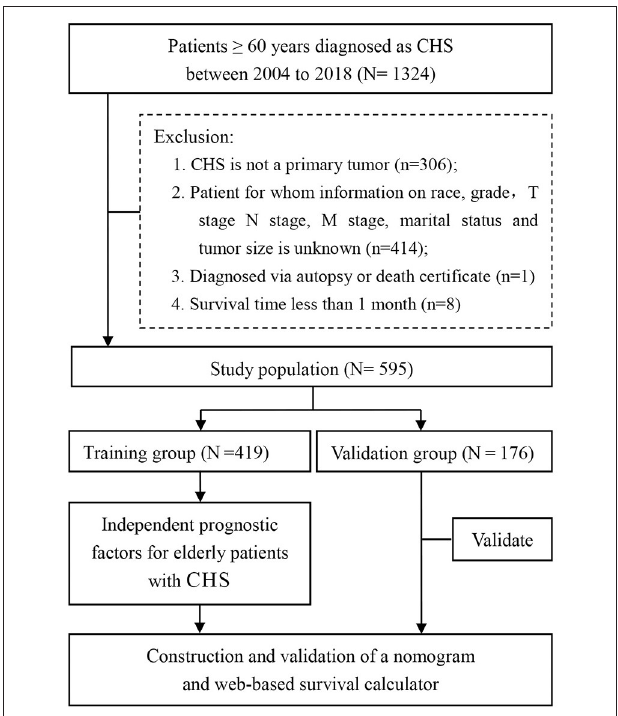
FIGURE 1 | A total of 595 elderly patients with CHS were included in this study based on inclusion and exclusion criteria. After random assignment, the study was further